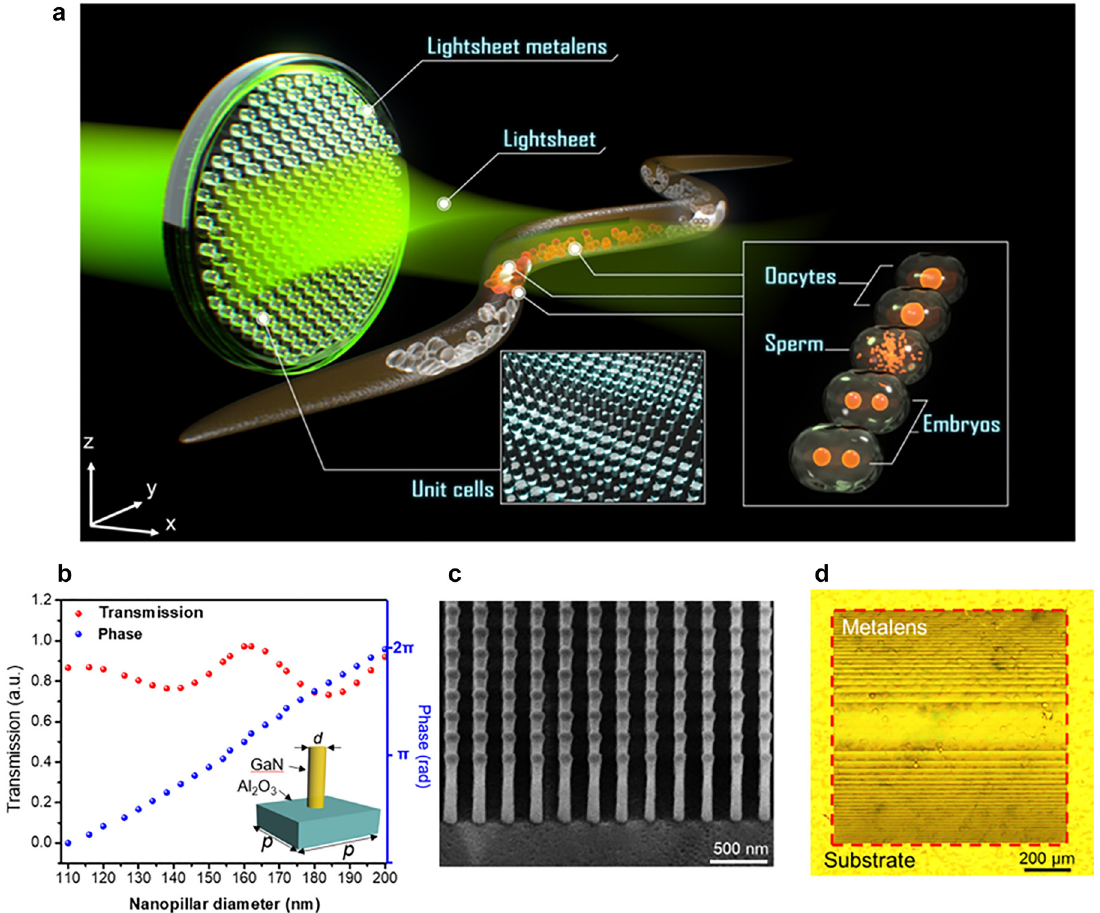
Figure 1: Meta-lens for light-sheet fluorescence microscopy (LSFM). (a) Schematic of the LSFM for fluorescence imaging of a C. elegans . The meta-lens consists of 800-nm dielectric nanopillars for locally modulating the phase. Inset shows the schematic diagram of fl uorescent images of oocytes, sperms, and embryos in the C. elegans . (b) The simulation results of the phase modulations (blue points) and the transmissions (red points) of the nanopillars with different diameters. Inset: the geometric parameters of the nanopillars. d : diameter. p : period of the unit cell, 300 nm. The height of the nanopillar is 800 nm. (c) Titled-viewed SEM image of nanopillars in the light-sheet meta-lens. (d) An optical microscope image of the light-sheet